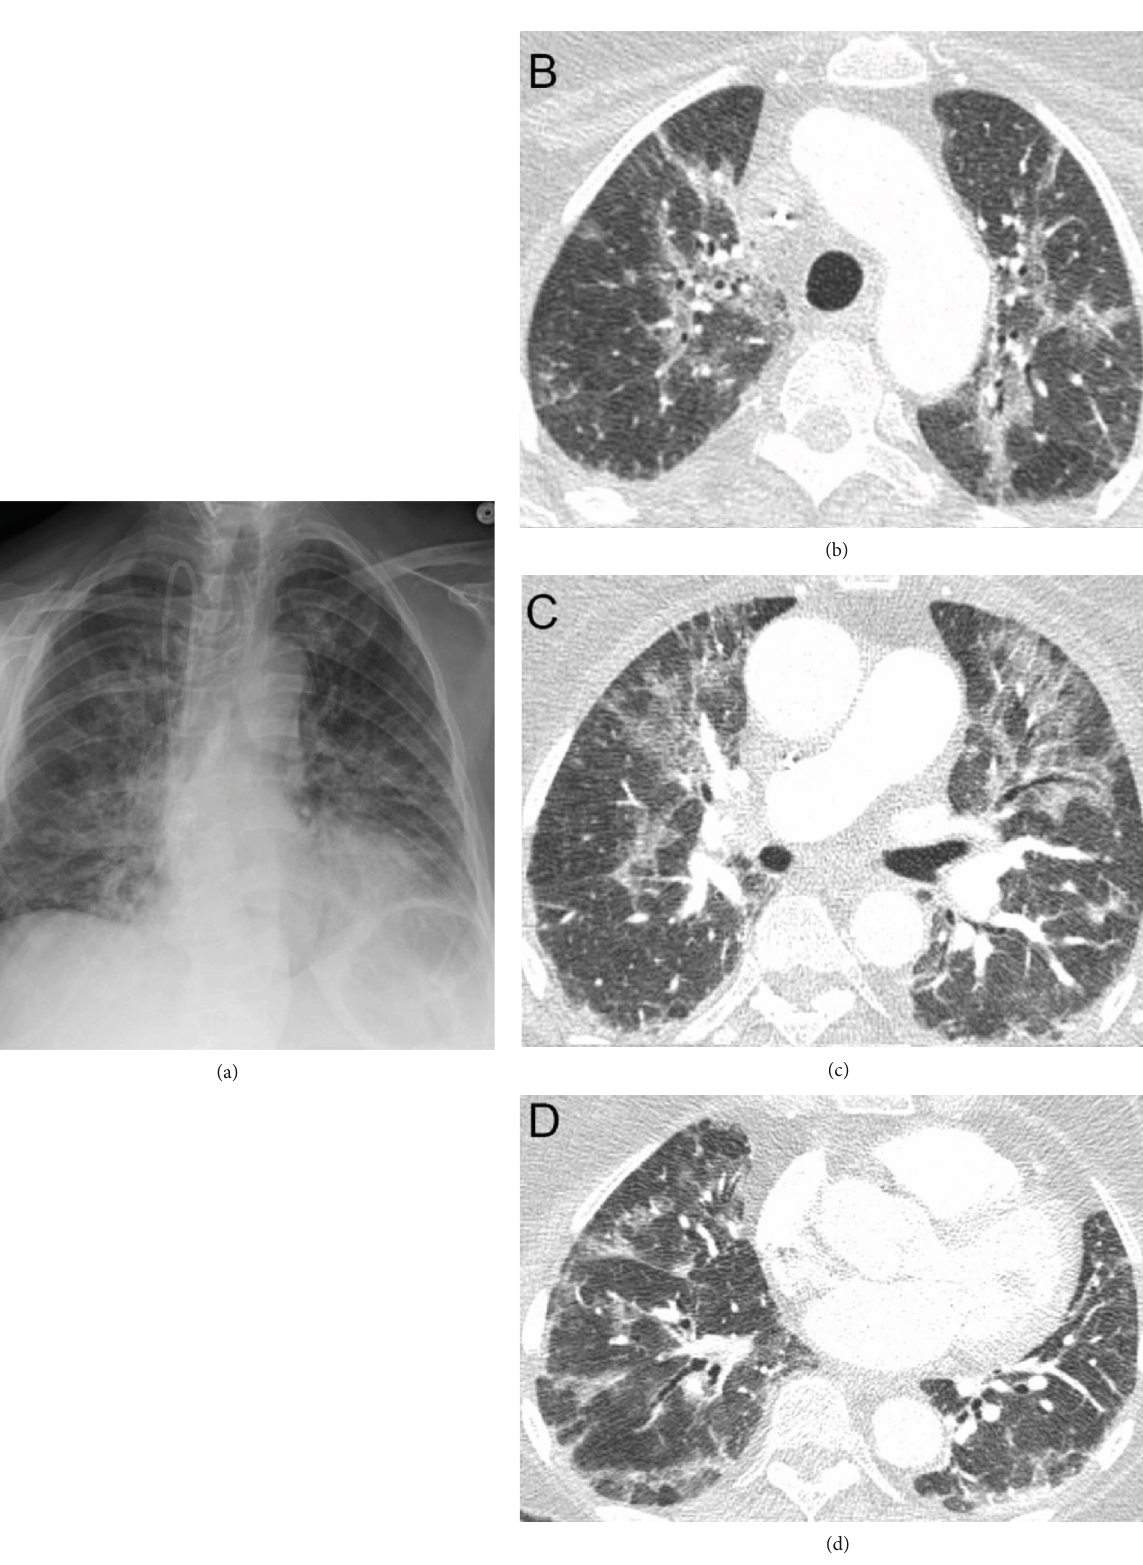
Figure 1: Imaging on presentation to ED. (a) CXR with multifocal airspace opacities. (b – d) CT scan of the lungs at upper (b), mid (c), and base (d) illustrating bilateral peribronchial consolidation and ground glass